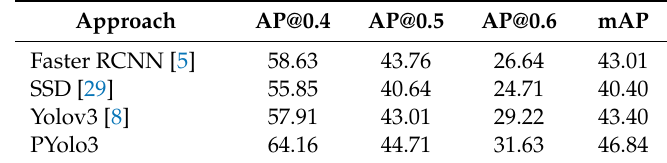
Table 8. Comparison of performance between PYolo and others (%).